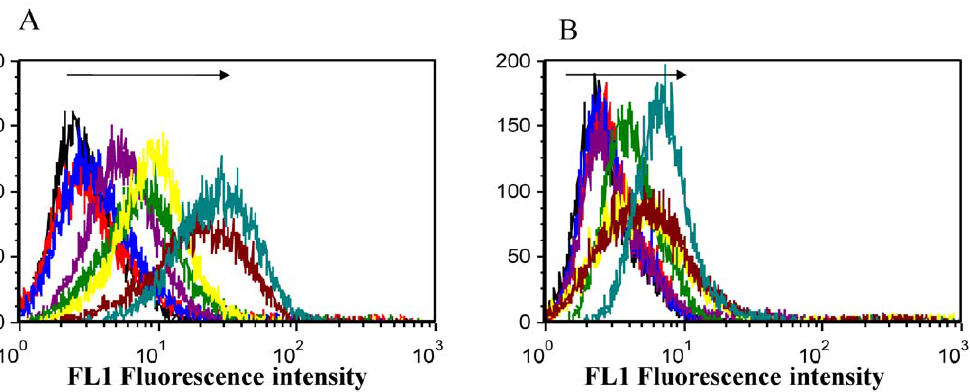
Figure 1. Enrichment of selected DNA pools of target DLD-1 (A) and control HCT 116 (B) during selection and monitored by Flow cytometry. Direction of arrows shows increasing rounds of selection from the 5 th -16 th pool. As selection progressed there was higher corresponding increase in fluorescence intensity of the target than the control. The sudden increase in fluorescence signal of the control from 14 th to 16 th round without corresponding increase in the target indicates higher enrichment.